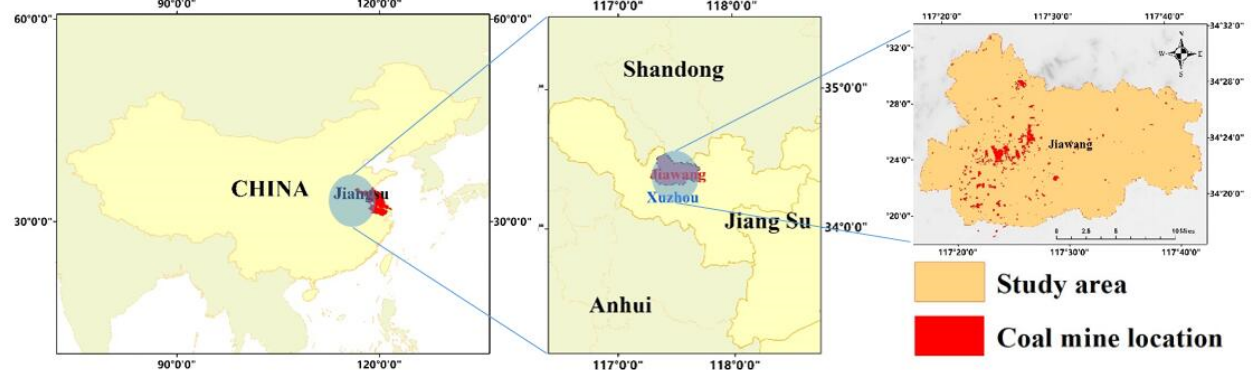
Figure 1. Geographical location of Jiawang District.